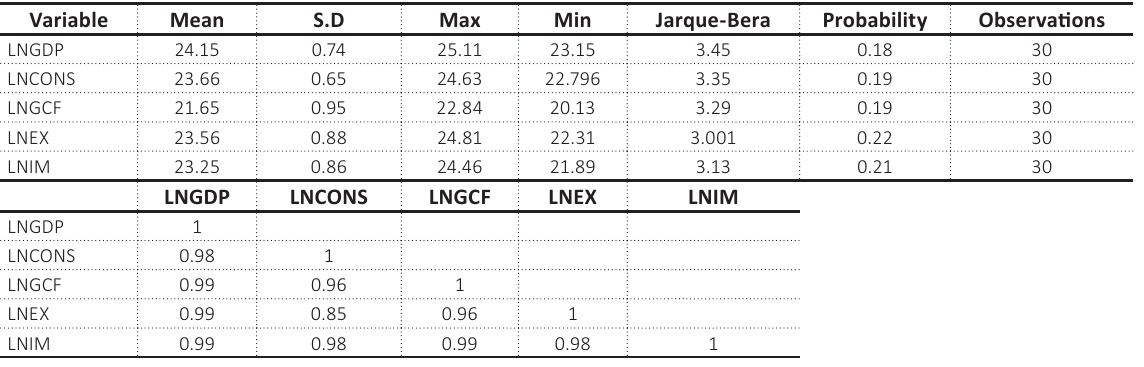
Table 1. Descriptive statistics and Pearson correlation